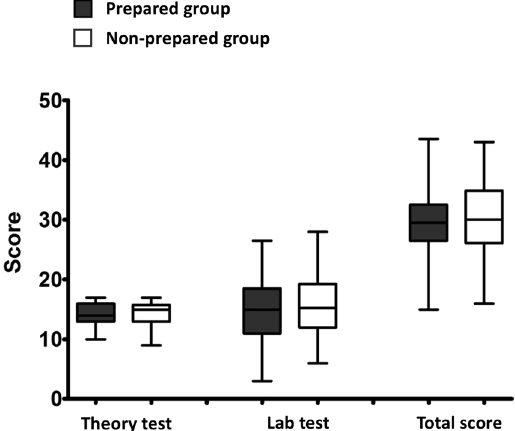
Figure 5. Comparison of post-test scores between prepared and non-prepared participants. No significant difference was found (Mann-Whitney).